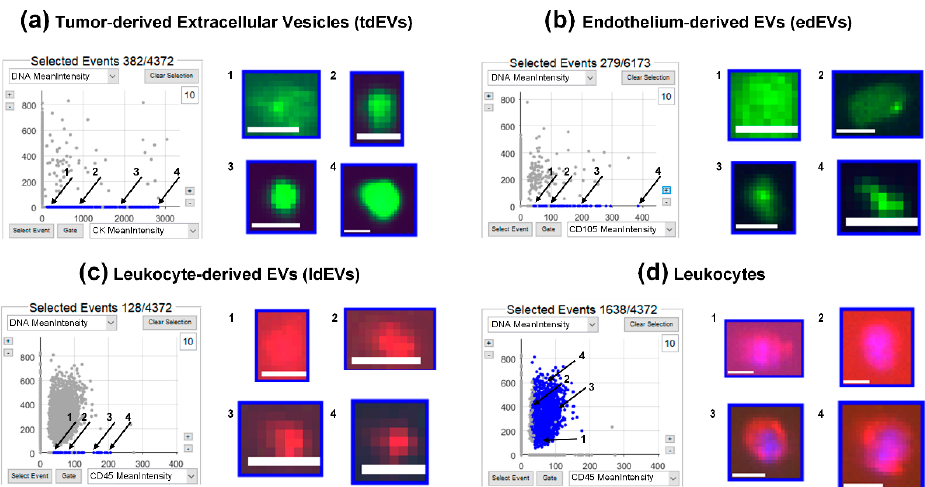
Figure 1. Examples of tumor-derived extracellular vesicles (tdEVs) ( a ), endothelium-derived extracellular vesicles (edEVs) ( b ), leukocyte-derived extracellular vesicles (ldEVs) ( c ), and leukocytes ( d ), isolated with the CellSearch system and identified by the ACCEPT (Automated CTC (circulating tumor cell) Classification, Enumeration, and Phenotyping) software. The dots corresponding to the objects that fall within the defined gates are depicted in blue in the respective scatter plots, whereas all other objects are depicted in grey. For each class, examples of four thumbnails with different fluorescence intensities (1–4) are shown. Cytokeratin (CK) ( a ) and endoglin (CD105) ( b ) are depicted in green, CD45 in red, and 4 ′ ,6-diamidino-2-phenylindole (DAPI) in blue ( c and d ). Scale bars indicate 6.4 μ